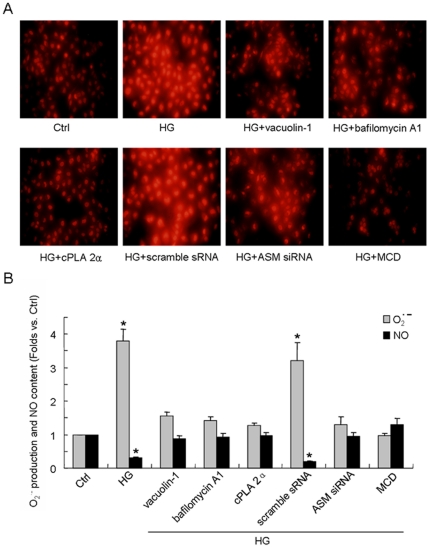
Effects of lysosome-membrane fusion inhibition or LRs disruption on HG-induced oxidative stress formation and nitric oxide (NO) quenching.The superoxide (O2
.
-) formation was detected with a DHE probe and the NO content was measured by nitrate reductase method. A: Representative staining of superoxide (O2
.
-) production in cell incubated in normal glucose (Ctrl) or high glucose for 12 h (HG) with or without the pretreatment by vacuolin-1(10 µmol/l for 1 h), bafilomycin A1 (100 nmol/l for 1 h), cPLA 2α (20 µmol/l for 1 h), scramble sRNA transfection, ASM siRNA transfection or methylcyclodextrin (MCD, 10 mmol/l for 1 h). B: summarized results on O2
.
- production and NO content in different groups. Values are means±SE; n = 5 batches of cells. * P<0.05 vs. Ctrl.